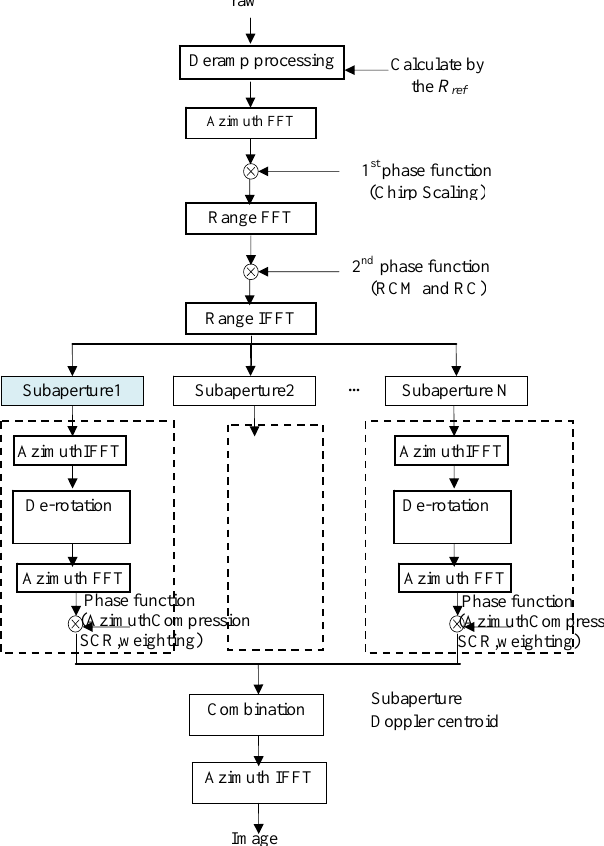
Figure 6. Flow diagram of subaperture focusing